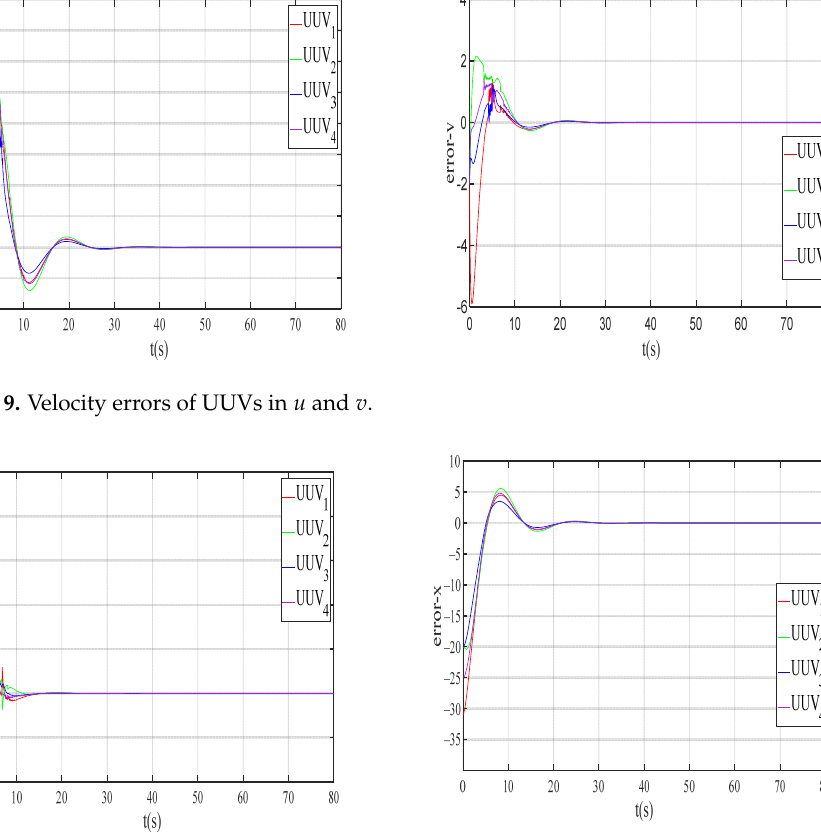
Figure 10. Velocity errors of UUVs in w , and position errors of UUVs in x direction.